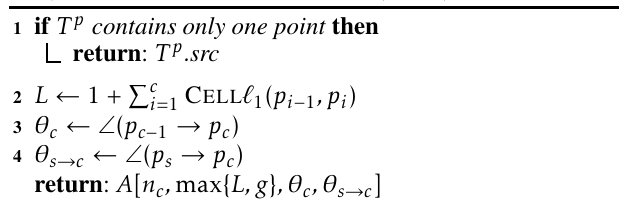
Algorithm 2: PROFILE-Prediction ( A, T p )